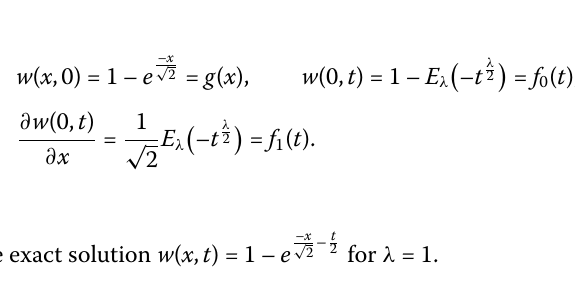
subject to the initial or boundary